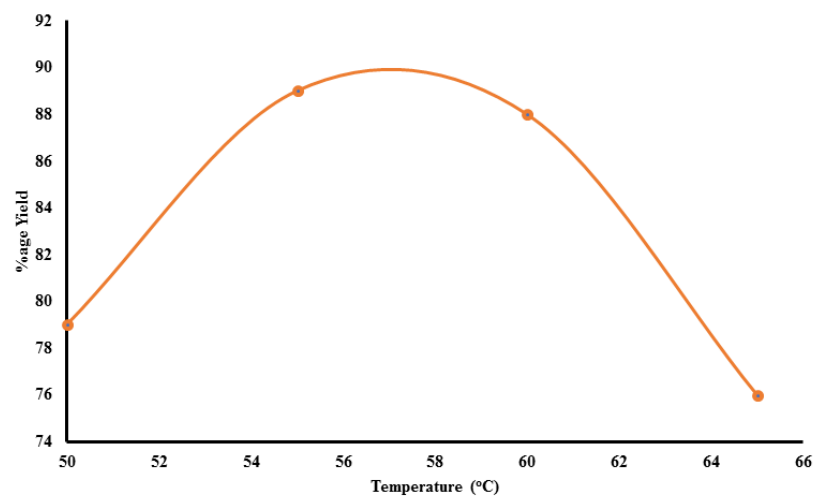
Figure 5. Graph showing the effect of temperature change on the percentage yield of biodiesel .